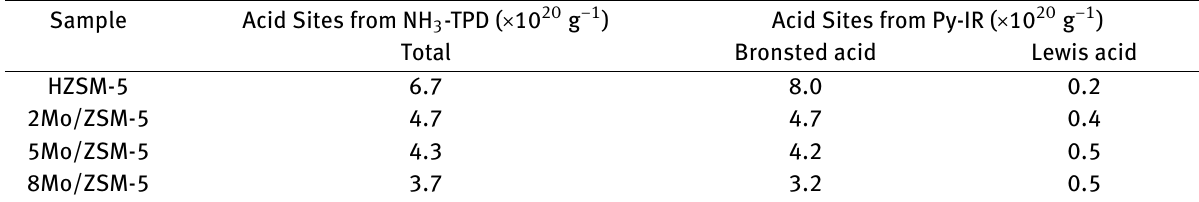
Table 14: The acidic sites of the Mo/ZSM-5 with different Mo loading from NH3-TPD and Py-IR [79] Sample